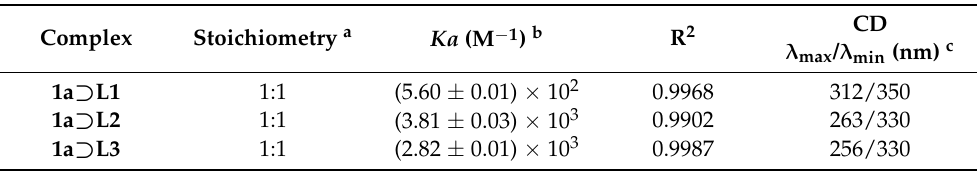
a The 1:1 host–guest stoichiometry of each complex was measured by Job plot experiment. b Binding constant values Ka of each complex. c Maximum and minimum of CD spectra with the highest equivalence of